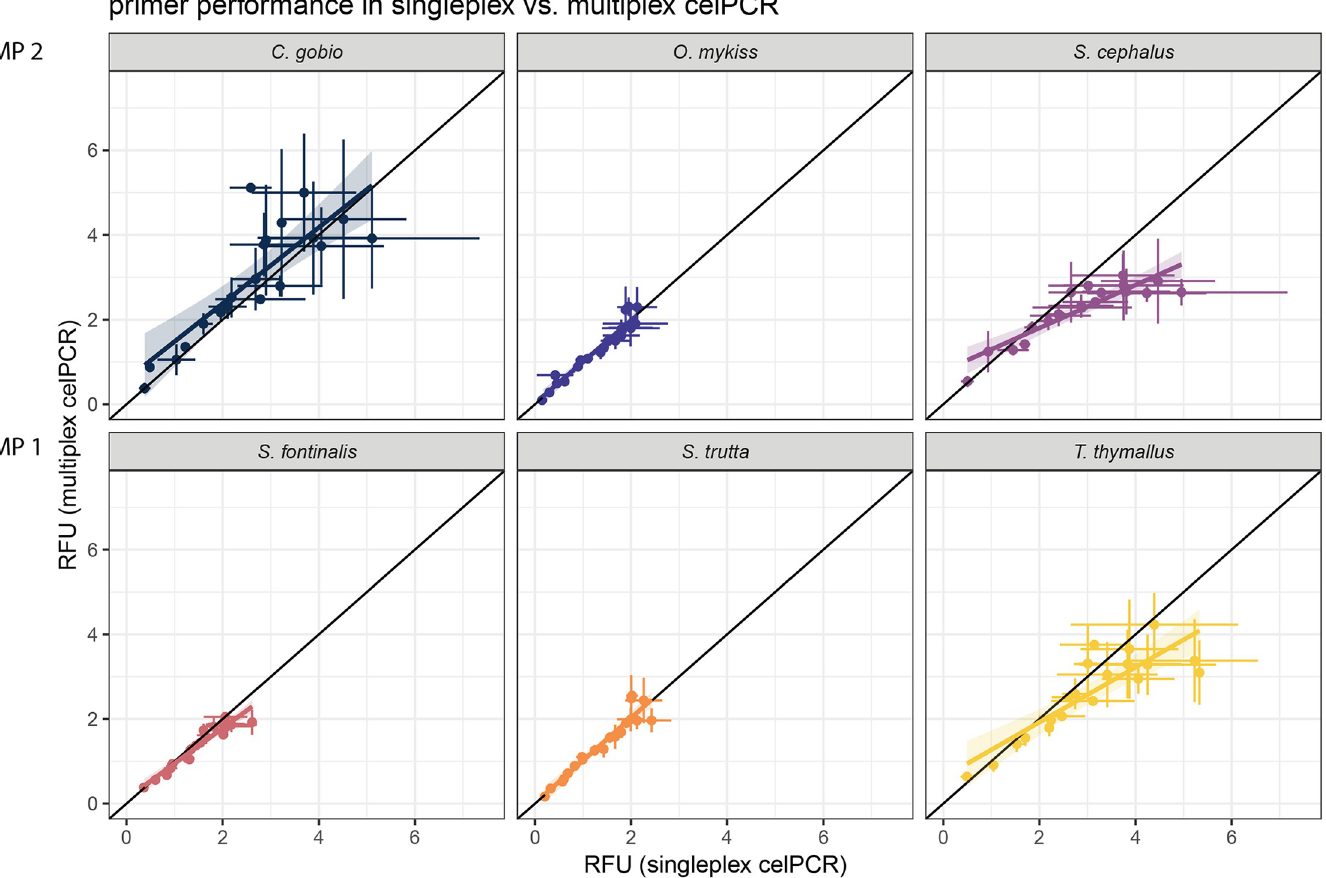
Fig 2. Singleplex vs. multiplex celPCR amplification. Visualizations and calculations are based on mean RFU (dots). The corresponding standard deviations are displayed as whiskers; the shaded area depicts the 95%-CIs; see S2 File for model specifications.